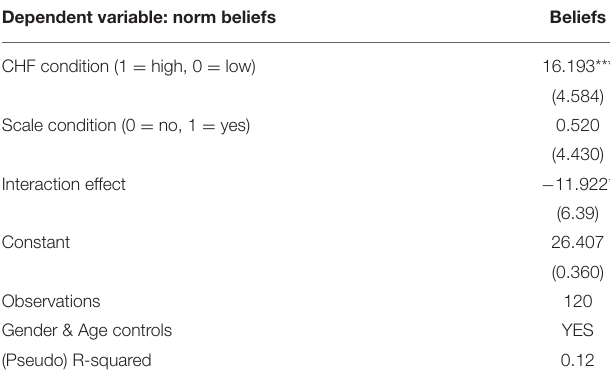
TABLE 4 | Regression model (Study